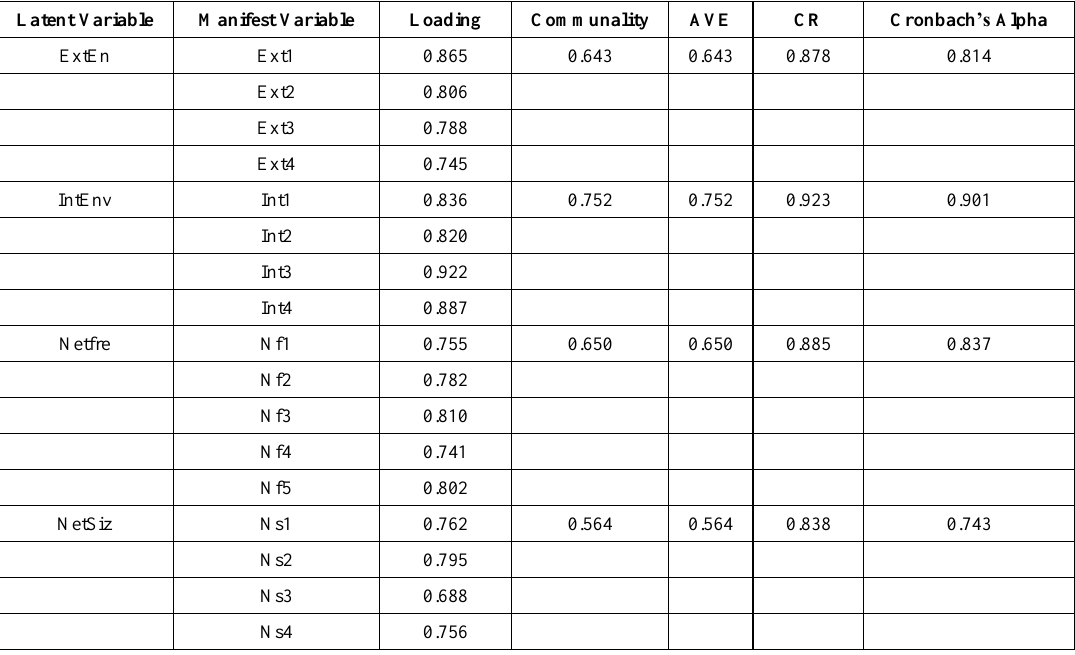
Table 2. Measurement